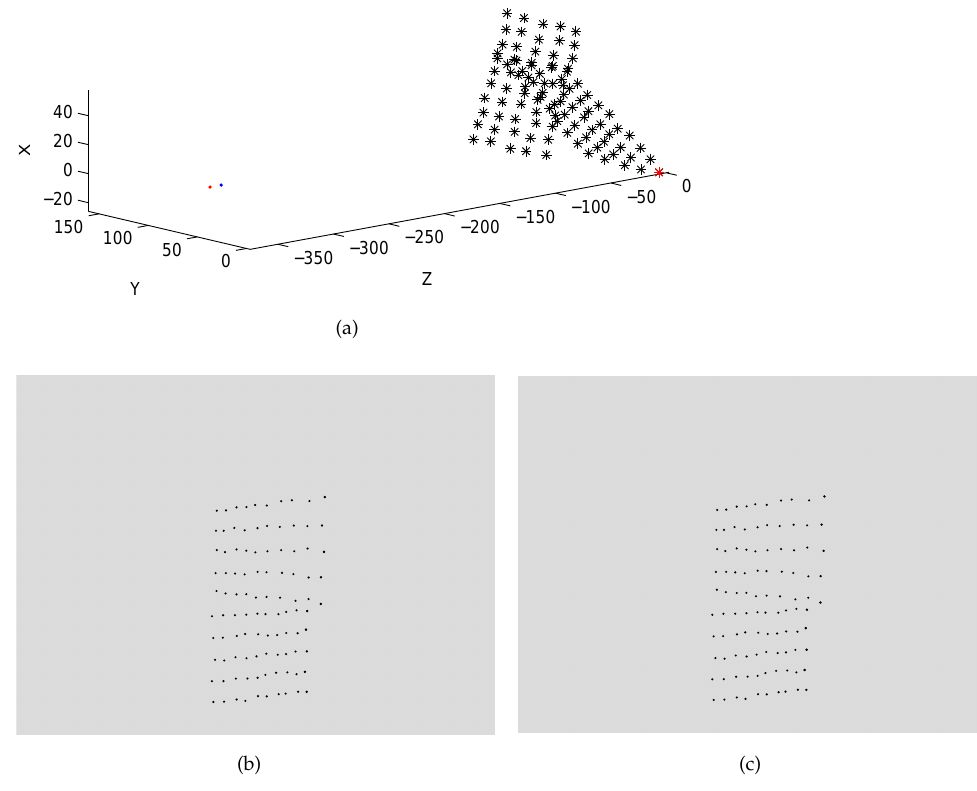
Figure 3. The simulated scene. ( a ) 100 points on two planes are add some random disposition. The noise make the lines and two planes have obvious but slight vibration. The red ’.’ and blue ’.’ are the positions of cameras. In order to make the figure clear, we use ’ ∗ ’ to indicate the points. ( b , c ) are the projection of 3D points on two images w.r.t the